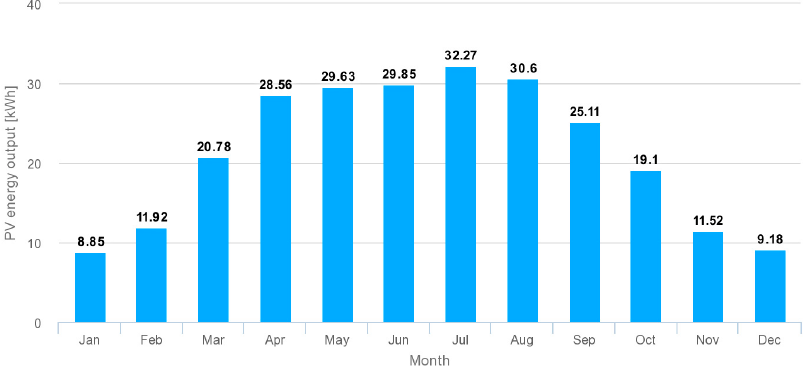
Figure 7. Monthly energy output from a fixed-angle PV system in the model WWTP location [35].